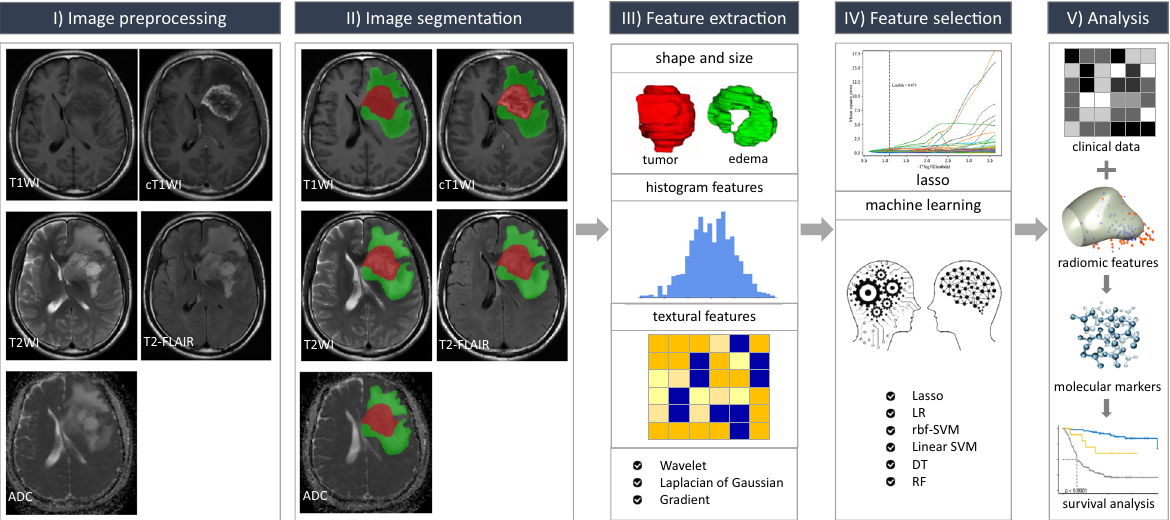
Fig. 3 Schematic diagram of the proposed radiomic work fl ow for molecular subtyping and survival prediction. The study design contains fi ve main phases: image preprocessing, image segmentation, feature extraction, feature selection, and radiomic